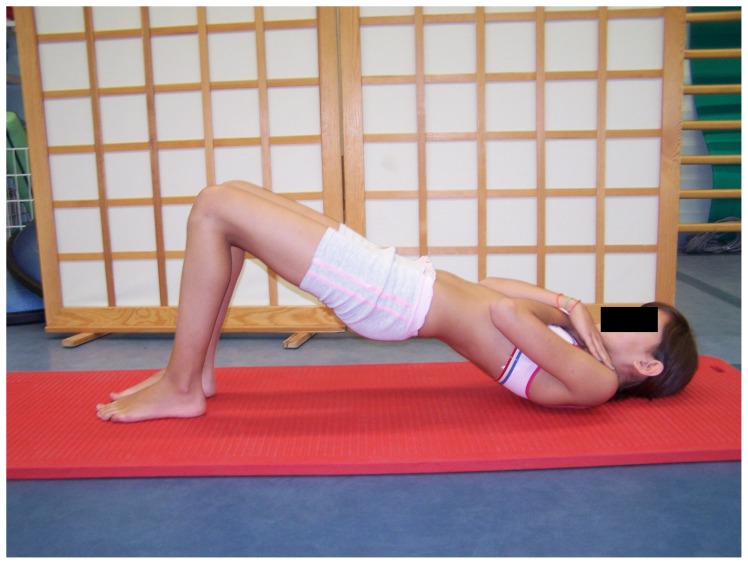
Gluteus maximus activation in a supine position.